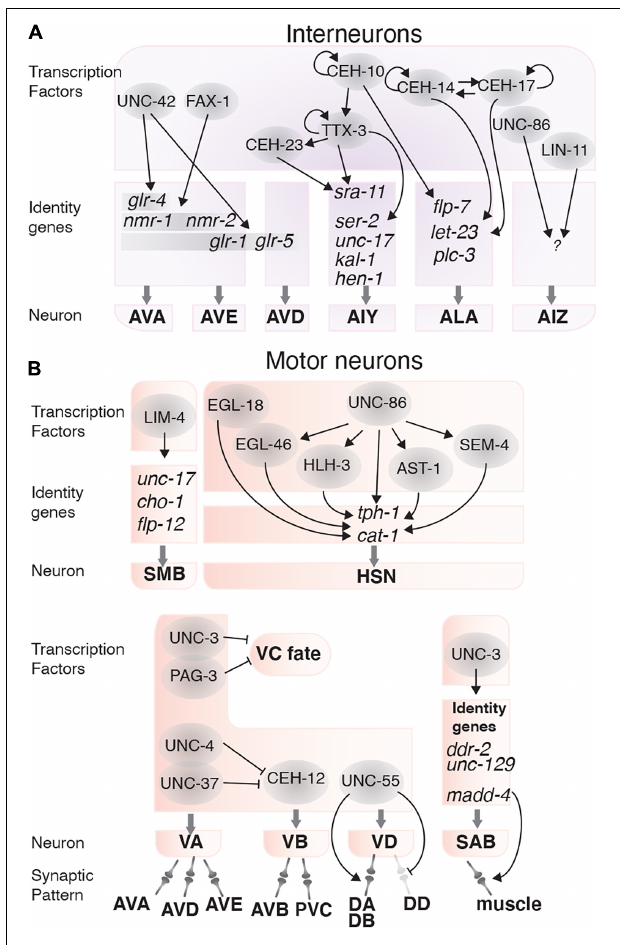
FIGURE 4 | Transcription factors involved in interneuron and motor neuron function. (A) Transcription factors (gray circles) and their targets that determine interneuron fate and function. (B) Transcription factors that control locomotion by regulating the fate, function and connectivity of motor